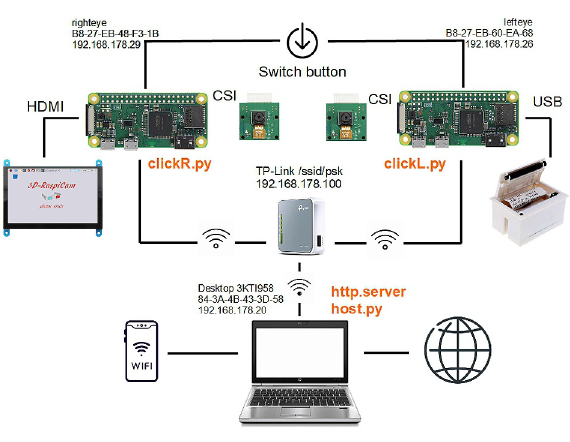
Figure 3: Camera network for taking